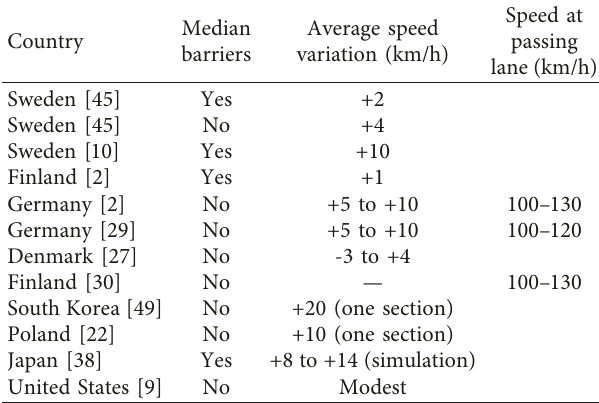
Table 7: Comparison of speed impacts of 2+1 highways.